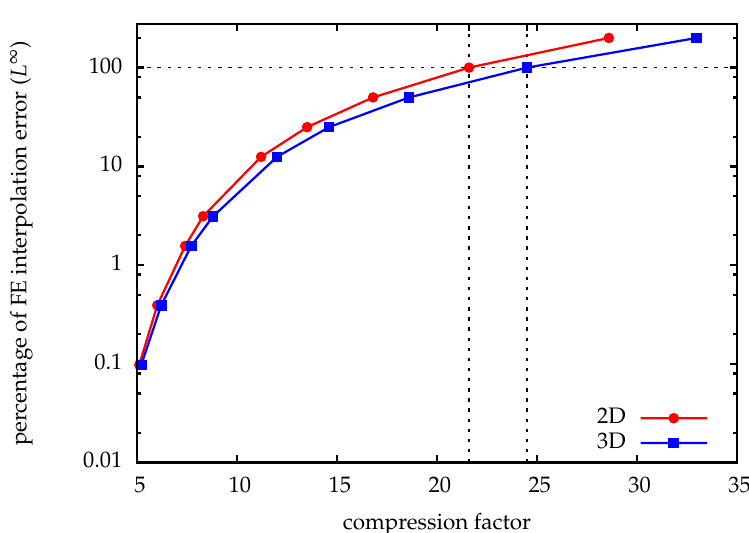
Figure 5. Error vs. compression factor: A priori estimates for transform coding of finite element functions with hierarchical basis transform, cf.